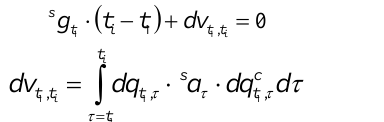
Figure 2: Graphical representation of the relationships between the observations, constraints, and updates on a global